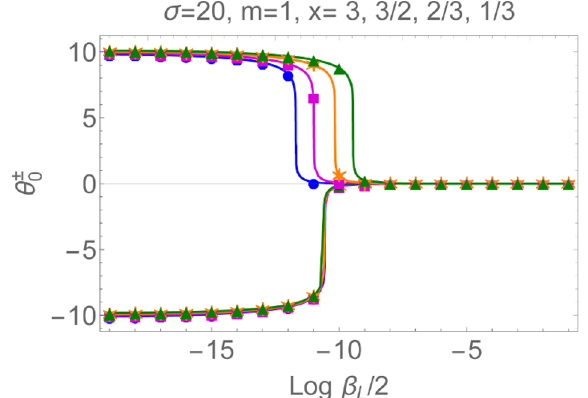
Figure 13 . Values of (cid:18) (cid:6) The signs are as expected from the behaviours of the e(cid:11)ective velocities seen in (cid:12)gure 9. The same symbols are employed for (cid:18) (cid:6)